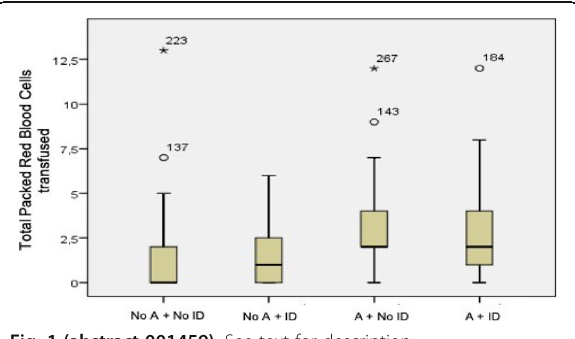
Fig. 1 (abstract 001459). See text for